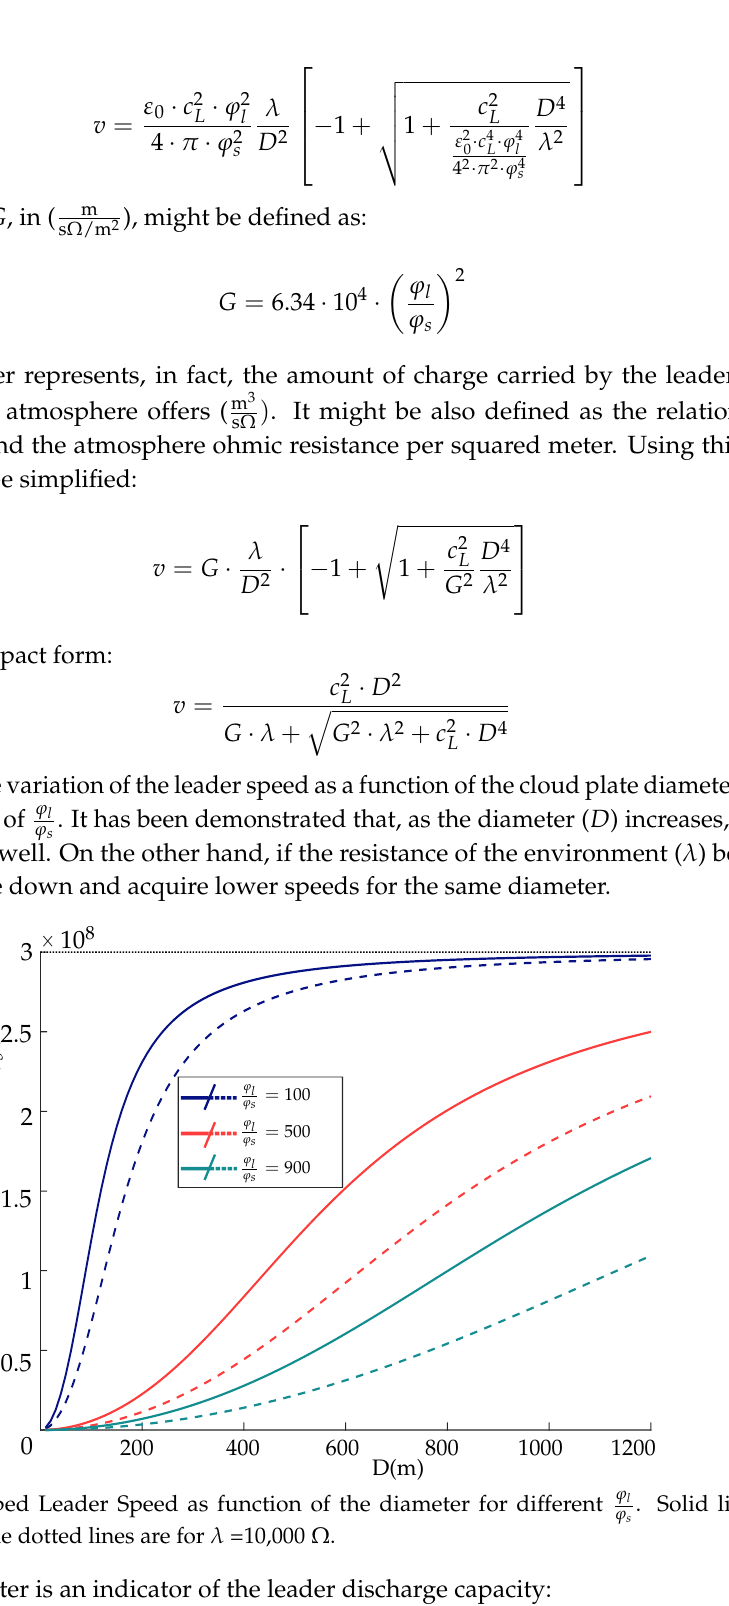
. Solid lines are for ϕ s